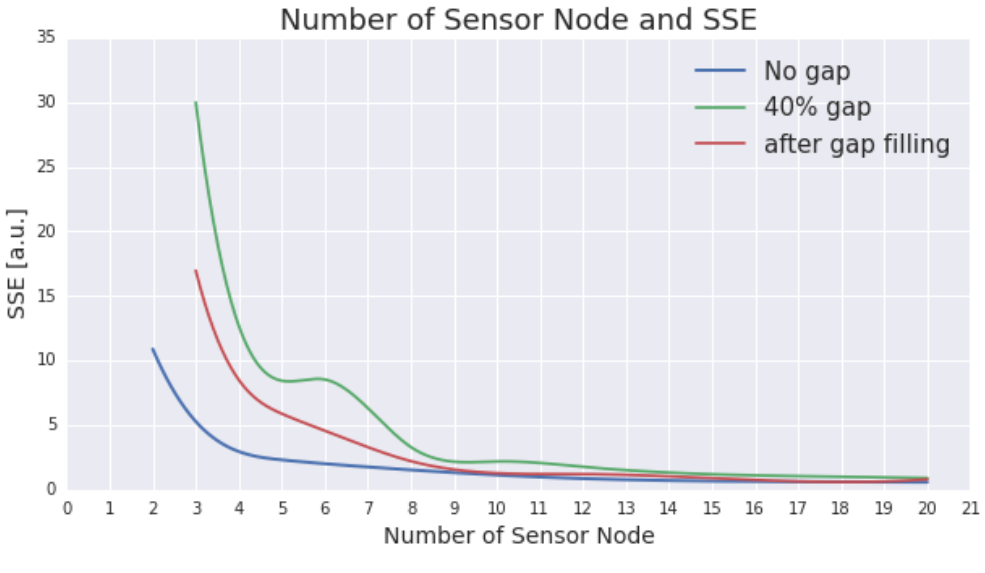
Figure 7. The figure presents the improvement promoted by a gap filling process (using Spatial Regression Test) to the ESN design with 40% of gaps. For comparison purposes, the performance of the ESN with no gap, with 40% of gap, and after the gap filling process are illustrated using blue, green, and red lines,